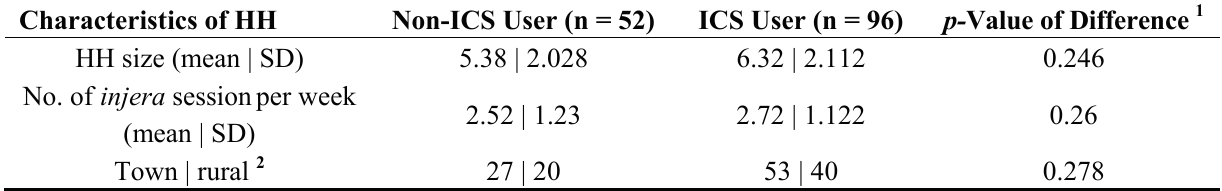
Table 1. Characteristics of questionnaires’ study households stratified by stove type.